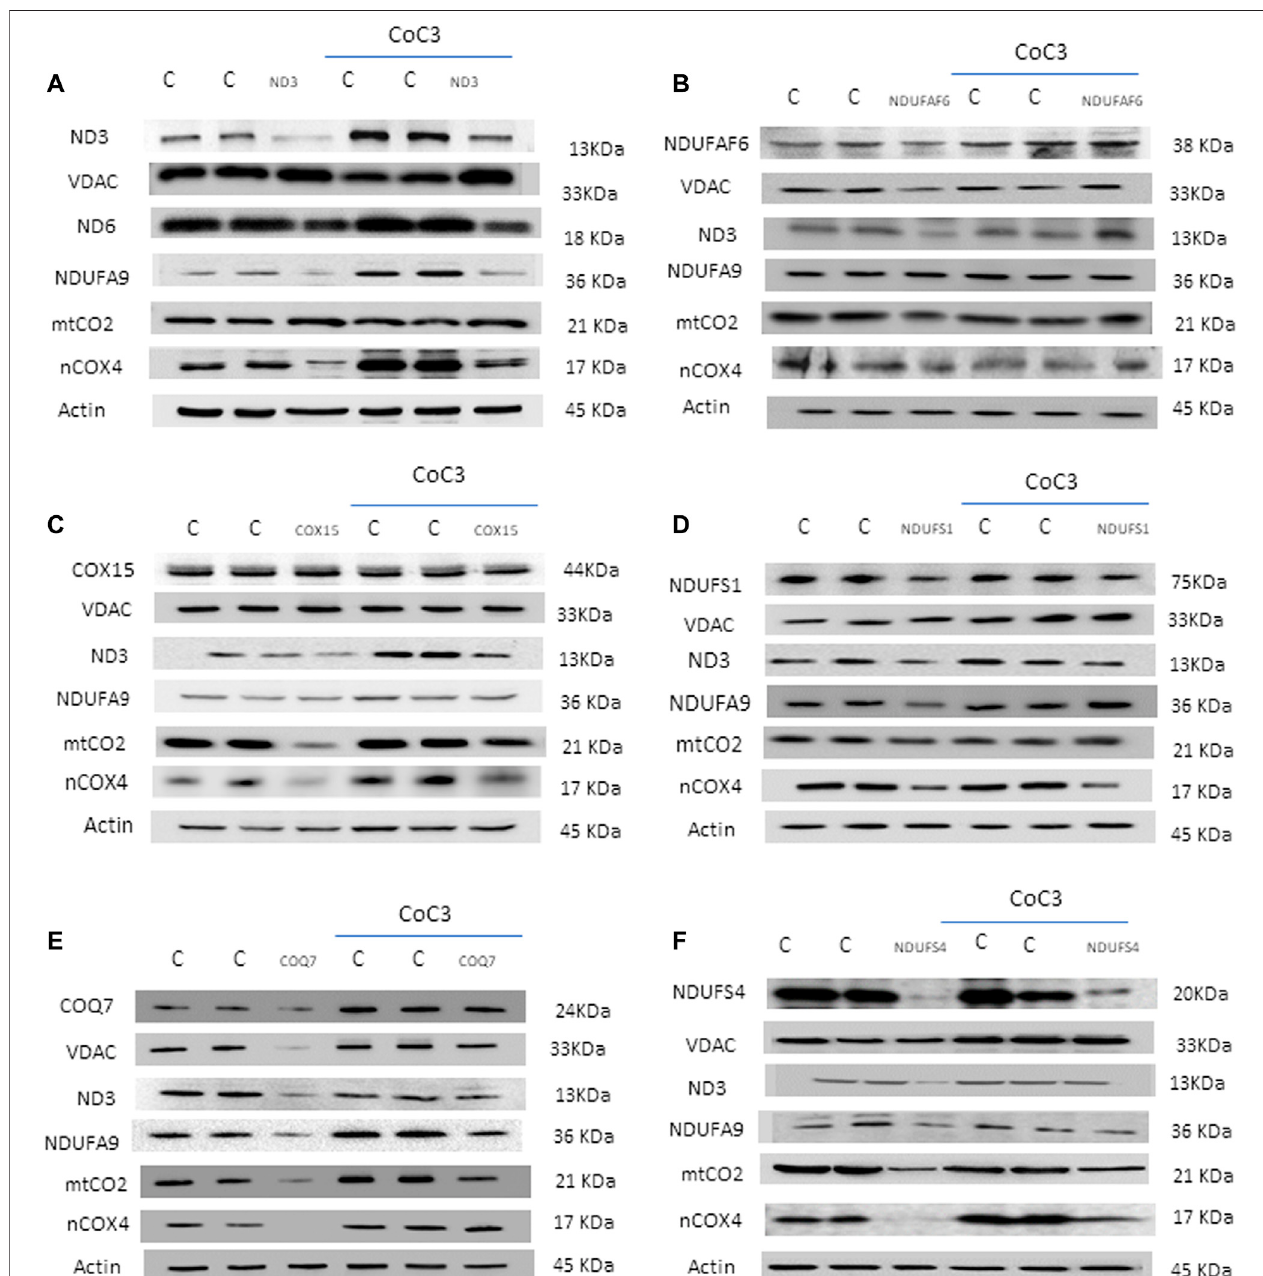
FIGURE2| EffectofCoC3onmitochondrialproteinexpressionlevelsincontrolandmutant fi broblasts.Westernblotanalysisoftheaffectedmutantproteinineach cell line: mtND3 (A) , NDUFAF6 (B) , COX15 (C) , NDUFS1 (D) , COQ7 (E) , NDUFS4 (F) . VDAC was used as mitochondrial mass marker, mtND3 and mtCO2 as mitochondrial-encoded reference proteins and NDUFA9 and nCOX4 as nuclear-encoded mitochondrial reference proteins. Overall, all patients show alterations with respect to the control, which are partially reversed after CoC3 treatment. “ C ” stands for healthy control cells. CoC3 treatment: 1 μ M Pterostilbene, 5 μ M nicotinamide, 1 μ M ribo fl avin, 1 μ M thiamine, 1 μ M biotin, 5 μ M lipoic acid and 1 μ M L -carnitine. Differences between patients are probably due to the high variability in mutation severity and their genetic background. A representative actin band is shown, although loading control was additionally checked for every Western blot. Band densitometry can be found in Supplementary Figure S5